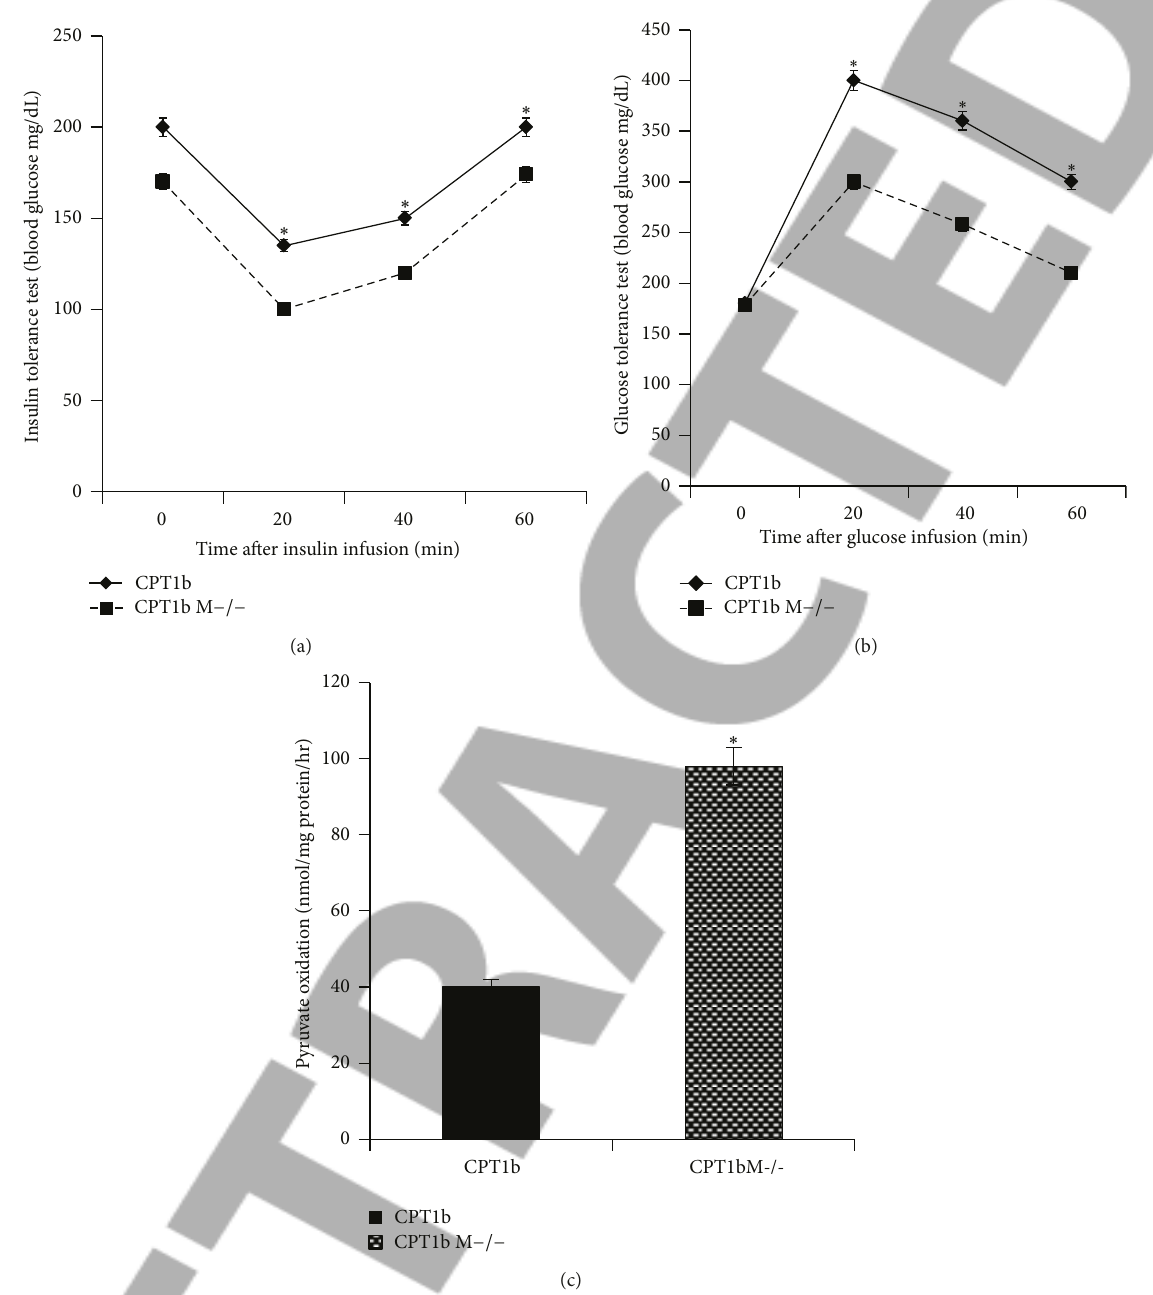
Figure 3: Insulin tolerance test showed the knockout mice preserved insulin sensitivity (a) with better glucose tolerance test (b) and improved glucose metabolism (c). 𝑛 = 20 for each group. ∗ 𝑃 < 0.05